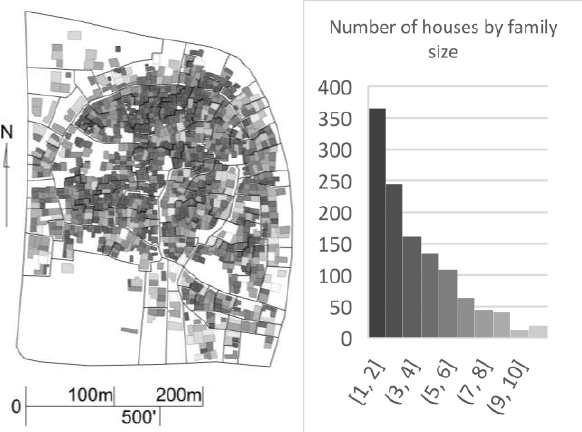
Figure 3. Weighted representation map and houses per family size